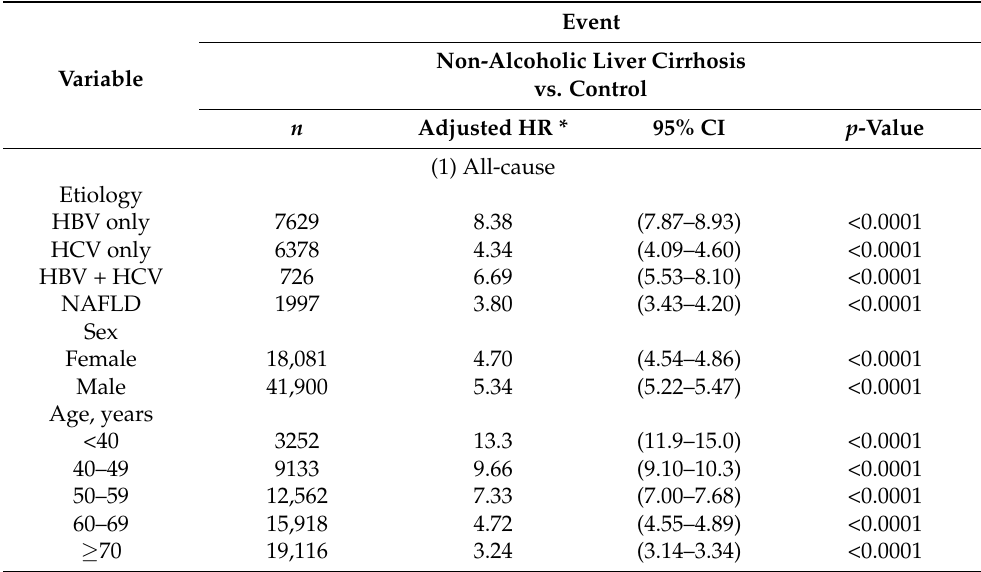
Table 4. Adjusted hazard ratios for all-cause mortality and mortality from different complications of non-alcoholic liver cirrhosis (vs. without non-alcoholic liver